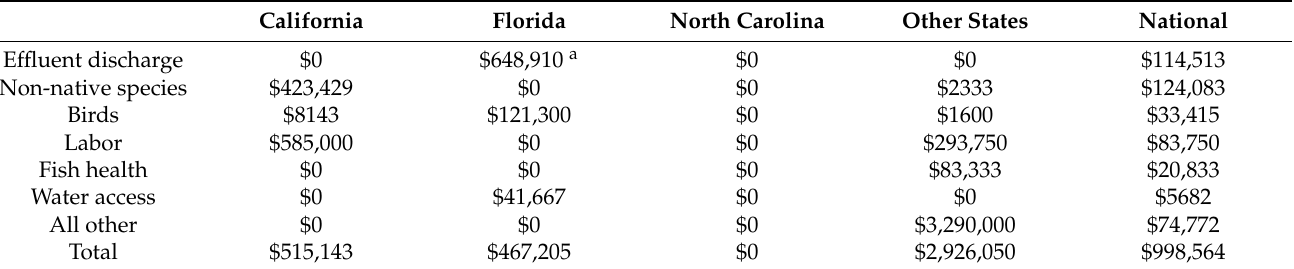
Table 14. Lost revenue by type of regulations, in